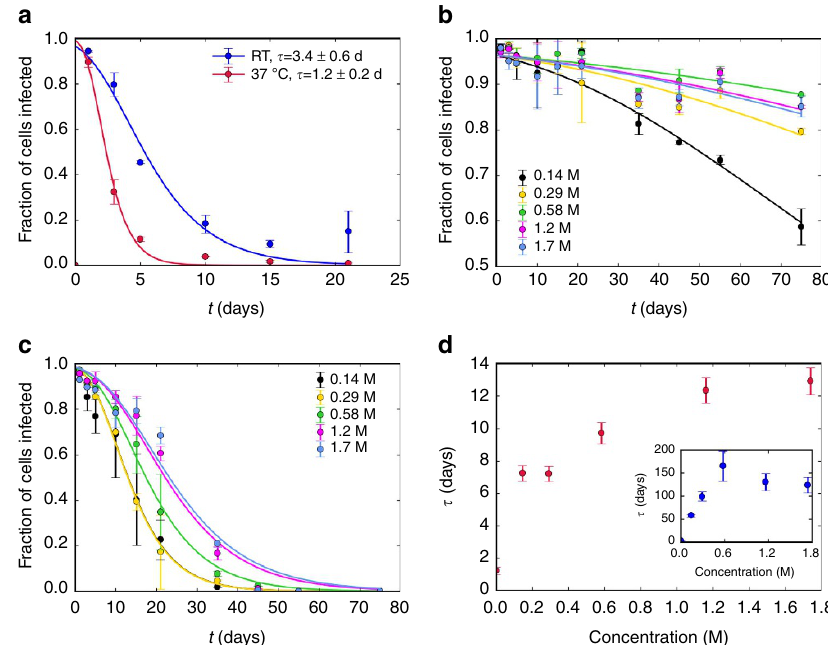
Figure 1 | Maintained Ad5 infectivity versus time in PBS and sucrose. ( a ) Fraction of cells infected versus storage time (days) of Ad5 in PBS at RT (blue) and at 37 (cid:2) C (red). The curves are fits to the expected infectivity given an exponential decay of viable Ad5 particles with characteristic lifetime t , equation (1). ( b , c ) Fraction of cells infected versus storage time in different sucrose concentrations ranging from 0.14 to 1.7M at RT ( b ) and at 37 (cid:2) C ( c ). ( d ) The lifetime of Ad5 virus as extracted from the fits at 37 (cid:2) C (main panel) and at RT (inset). (A comparison with the infectivity change for herpes simplex virus-2, another example of double-stranded DNA viruses, can be found in Supplementary Fig. 1.) The experiments were performed in duplicate. Error bars represent the s.d. d,